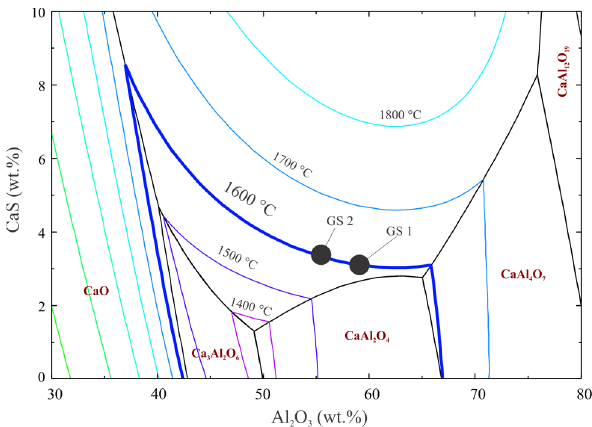
Figure 5. Calculated liquidus projection of CaO-Al 2 O 3 -CaS system in low CaS